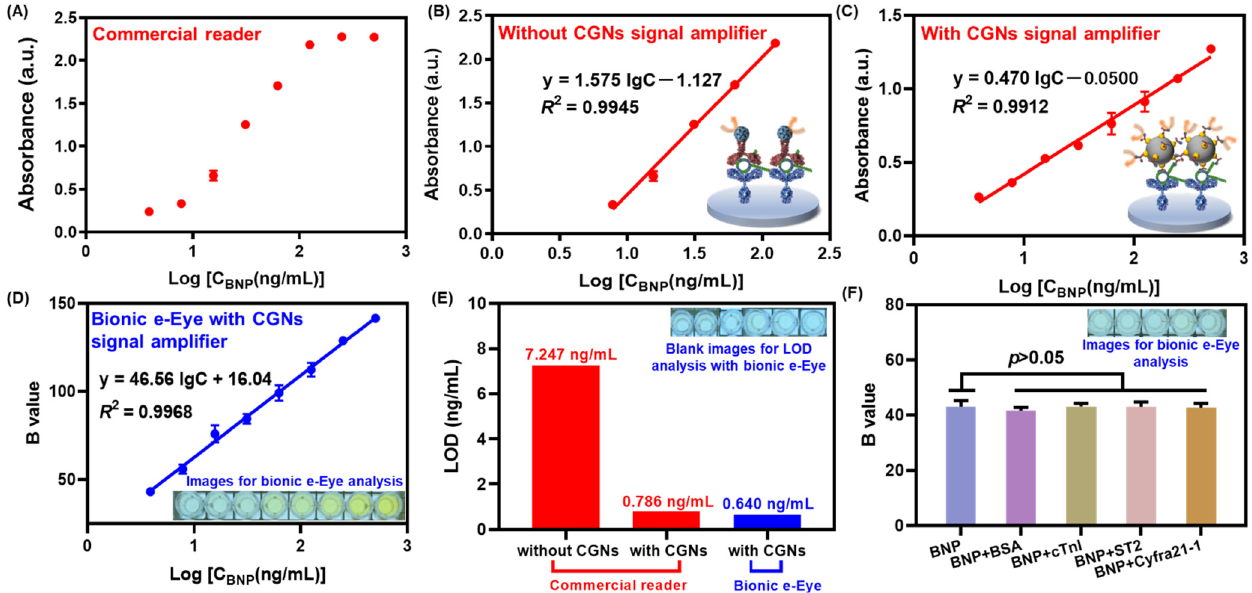
Figure 7. Analytical performance of the immunocolorimetric sensor based on bionic e-Eye. ( A ) The S-shaped response of BNP in different concentrations detected by the commercial microplate reader without CGNs@AntiBNP-HRP signal amplifier and ( B ) the corresponding calibration curve from 7.8–125 ng/mL; ( C ) The calibration curve of BNP from 3.9–500 ng/mL detected by the commercial microplate reader with CGNs@AntiBNP-HRP signal amplifier. ( D ) The calibration curve of BNP from 3.9–500 ng/mL detected by the bionic e-Eye with CGNs@AntiBNP-HRP signal amplifier (inset: images for bionic e-Eye analysis). ( E ) LOD comparison of the sensor with or without signal amplifier and the sensor detected using commercial microplate reader or bionic e-Eye (inset: Blank images for LOD analysis with bionic e-Eye). ( F ) The specificity of CGNs-based immunocolorimetric sensor using bionic e-Eye (inset: images for bionic e-Eye analysis). Error bars represent standard deviation (n = 3).